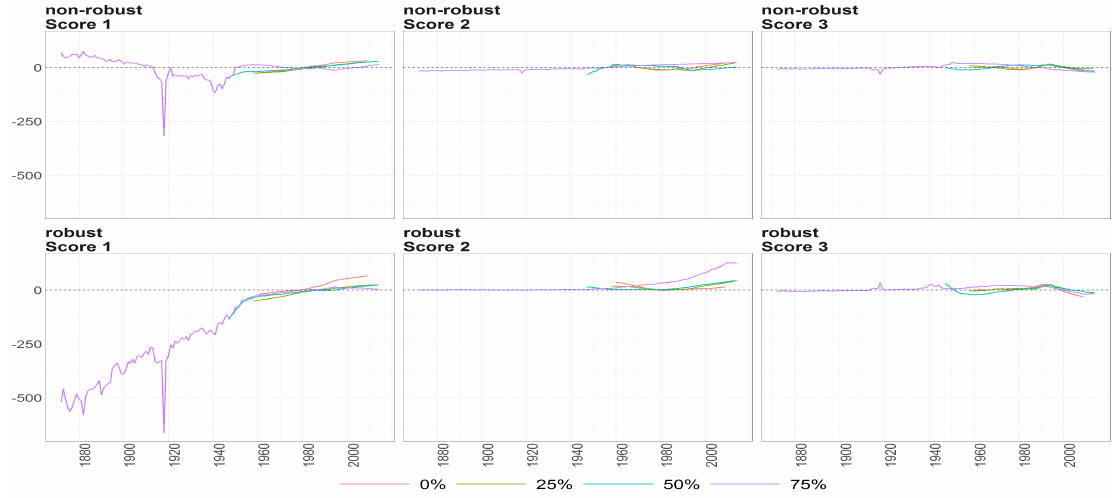
Figure 22. The scores (y axis) over time (x axis) obtained using PPCA for male population of Number of Deaths. Colours of lines correspond to the scores calculated on subsample where are different levels of maximum missing values per observation (0%, 25%, 50% and 75%, refer to legend). The plots placed in the first row correspond to the results using non- robust standardization of entry data, where the second row correspond to robust standardisation. The plots of scores are ordered by